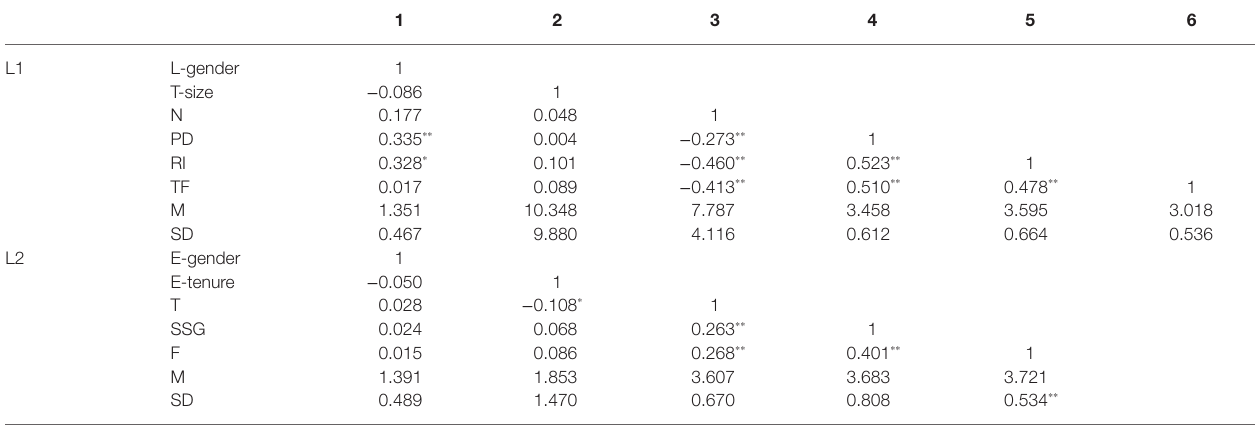
TABLE 2 | Means, SDs, and correlations of variables.